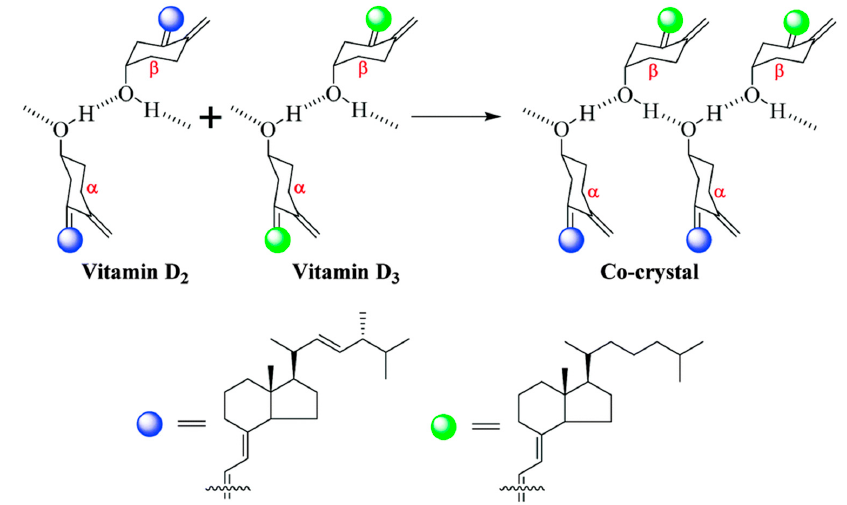
Figure 42. Design and synthesis of VD 2 -VD 3 cocrystal. Blue and green ball represent the substituent groups present in VD 2 and VD 3 . Adapted with permission from Chemical Communications , 2016, 52, 3572–3575. Copyright 2016, The Royal Society of Chemistry.